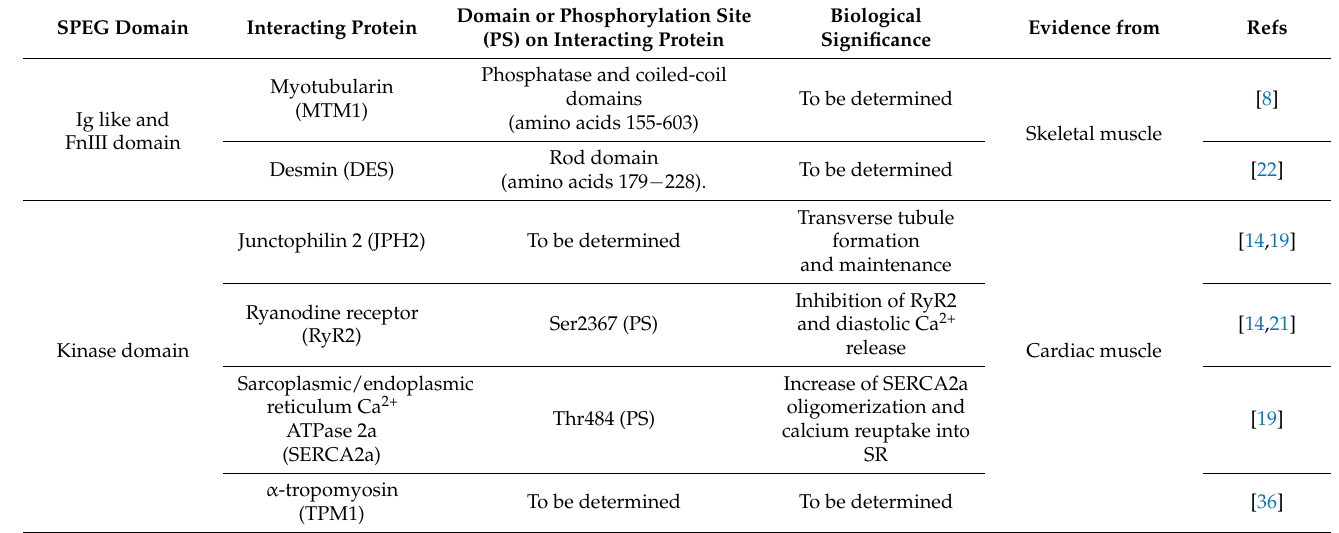
Table 1. SPEG and its interacting partners in skeletal and cardiac